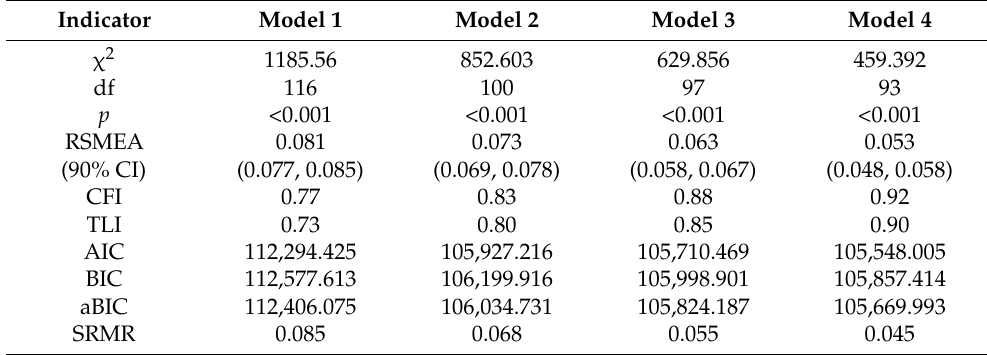
Table 2. Comparison of the goodness of fit parameters between the tested models of the knowledge and attitude items of the KAP questionnaire on antibiotic use.